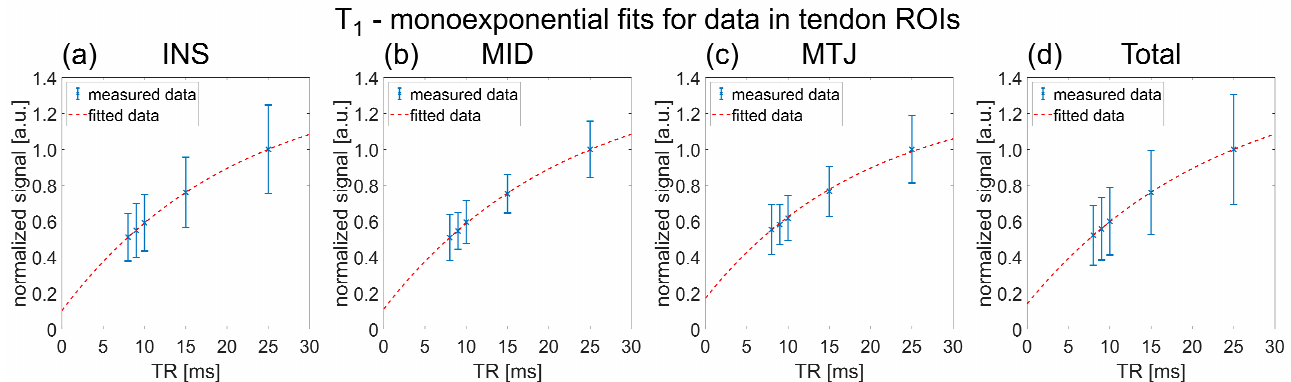
Figure 1. Data points and fitting results of 23 Na T 1 relaxation times in the different Achilles tendon (AT) regions of interest (ROIs) of an exemplary healthy control. ROIs were named after their position, where ( a ) corresponded to the most distal 3 cm of the AT, i.e., the distal 3 cm of the tendon’s length extending into the calcaneal insertion (INS), ( b ) corresponded to the middle 3 cm, i.e., the middle portion of the AT (MID), and ( c ) corresponded to the proximal 3 cm, which was referred to as the myotendinous junction (MTJ). In ( d ), the data and fitting of the total ROI combining all three ROIs, i.e., INS, MID and MTJ are displayed. The corresponding parameter results were ( a ) 23 Na T 1 = 21.2 ms, R 2 = 0.999, ( b ) 23 Na T 1 = 22.1 ms, R 2 = 0.999, ( c ) 23 Na T 1 = 19.6 ms, R 2 = 0.997 and ( d ) 23 Na T 1 = 23.1 ms, R 2 = 0.999.